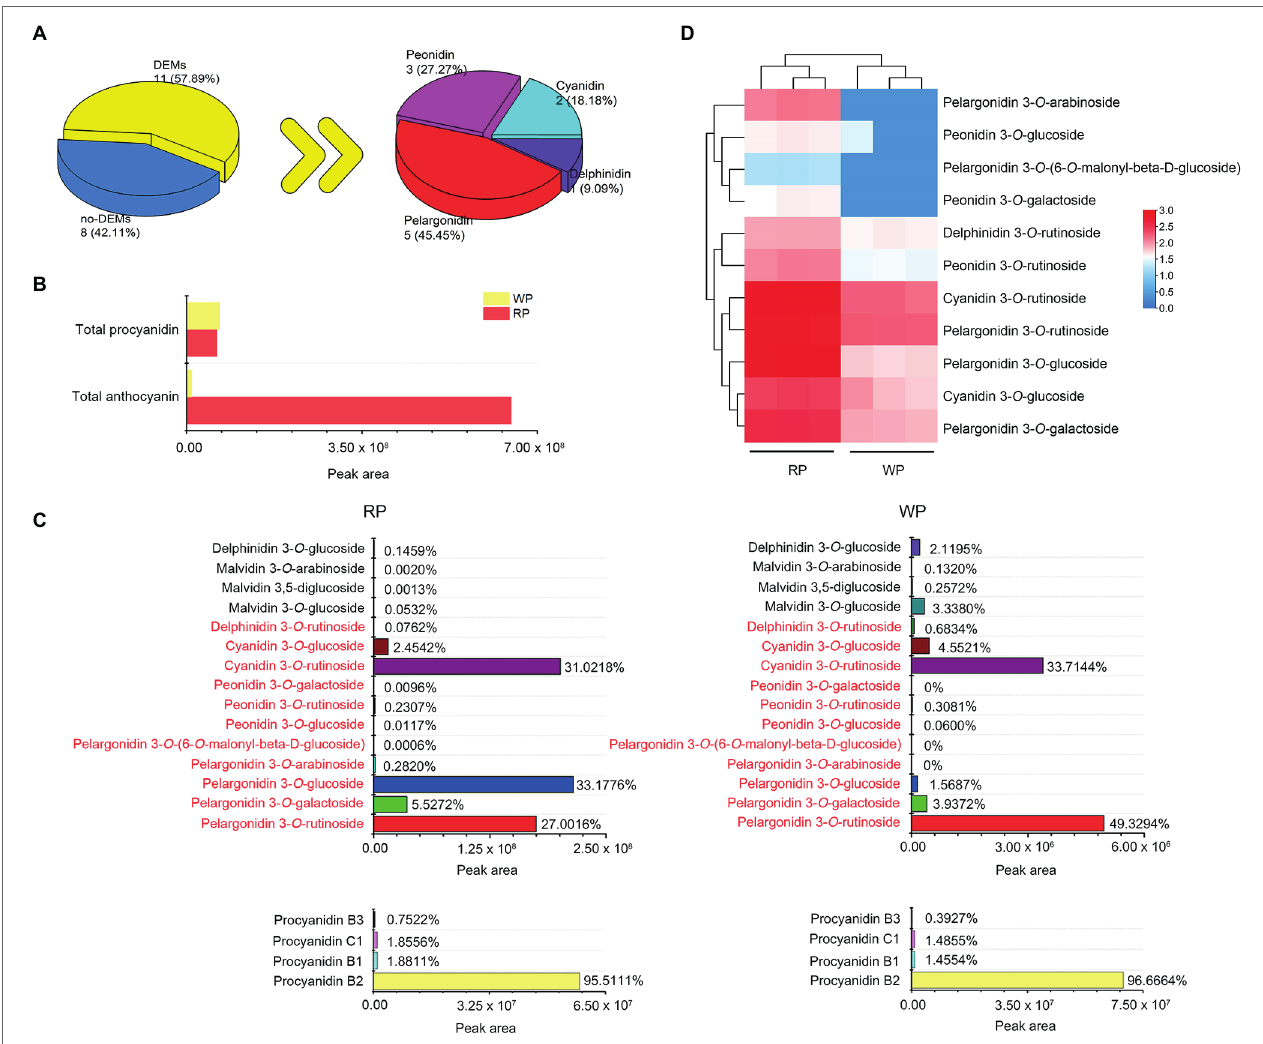
FIGURE 2 | Metabolomics profiles for cherry fruits of Prunus tomentosa . (A) Statistics of the expressed metabolites and differentially expressed metabolites (DEMs: |log 2 Fold Change| > 2 and value of p <0.05); (B) The relative contents of total procyanidin and total anthocyanin from metabolome data. The relative content of metabolites is expressed by peak area; (C) The relative contents and proportion of anthocyanin (upper) and procyanidin (lower) compounds in red and white fruits of P. tomentosa . The red font indicates the 11 DEMs; (D) Heatmap of the 11 DEMs at mature stage. Color indicates the relative content of each DEM, from blue (low) to red